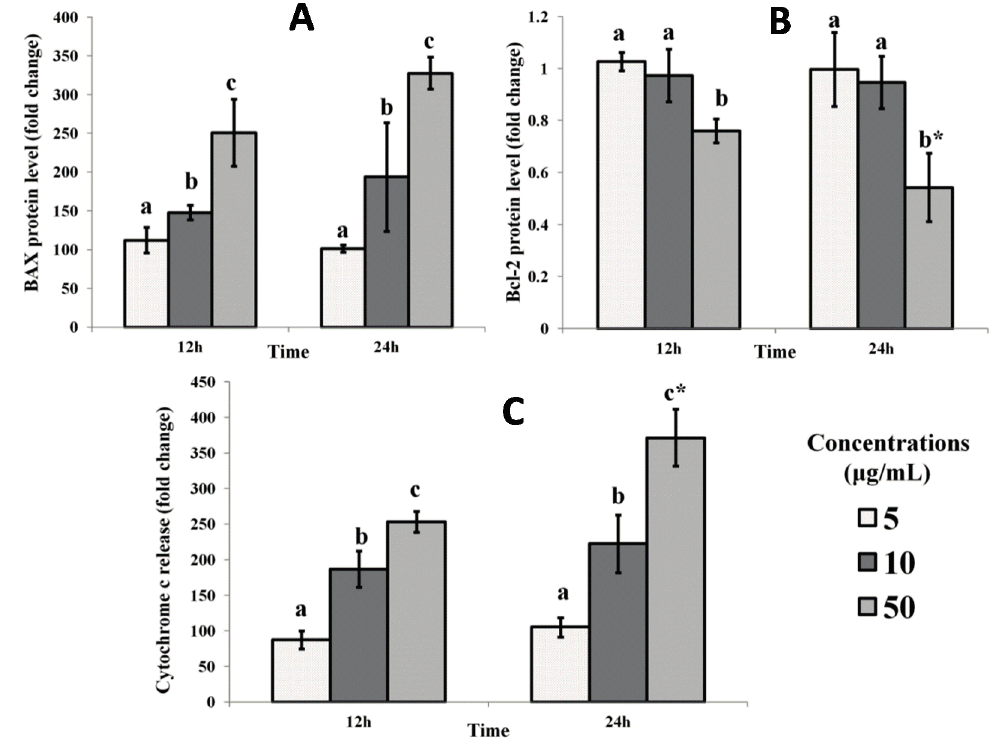
Figure 2. Effect of mango kernel extract on ( A ) BAX, ( B ) Bcl-2 and ( C ) cytochrome c levels in MCF-7. Treatment with 5, 10 and 50 μ g/mL of extract for 12 and 24 h produced time- and dose-dependent changes in BAX, Bcl-2 and cytochrome c proteins. Bars with different letters for any time period of an assay indicate a significant difference ( p < 0.05). * Significant difference between 12 and 24 h treatments with the same concentrations of